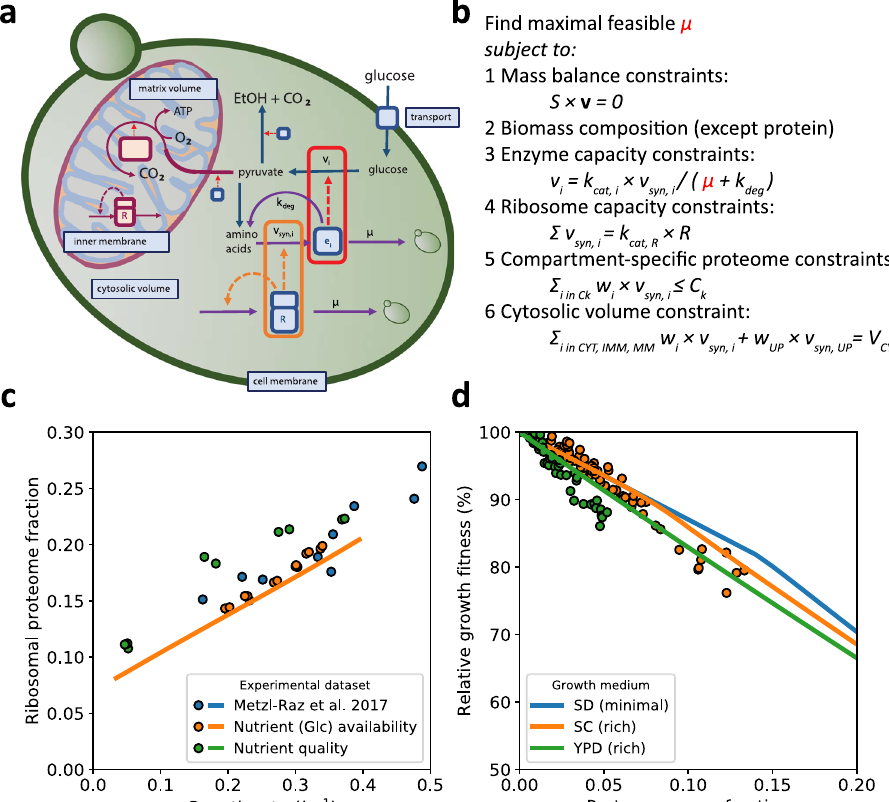
Fig. 1 pcYeast model formulation and calibration of protein synthesis parameters. a A schematic overview of reactions in the model, their interdependence and constraints. Metabolic reactions v i are proportional to enzyme concentrations e i that are synthesised at rate v syn ; i by the ribosomes R . Each protein can be degraded with rate v deg ; i ¼ k deg (cid:2) e i or diluted by growth rate v dil ; i ¼ μ (cid:2) e i . Compartment-speci fi c constraints are indicated in the light- blue boxes. b Optimisation problem with the key constraints, including (1) steady-state mass balances; (2) production of biomass components such as DNA, lipids, cell wall and polysaccharides. Proteins are excluded as their synthesis rates are optimisation variables (3) enzyme capacity constraints that couple metabolic fl ux to catalytic rate k cat ; i and the enzyme level, whose value at steady state is determined by its synthesis rate. Note we use equalities and hence enzymes work at their maximal rate and minimal required protein levels are computed; (4) ribosome capacity that de fi nes an upper bound for protein synthesis rate; (5) compartment-speci fi c proteome constraints that de fi ne the maximal concentration of proteins that can be contained in that compartment, with w i the speci fi c volume or area of protein i ; (6) a cytosolic protein density constraint that has the same function as that of proteome constraints, but whose equality forces the cell to fi ll up any vacant proteome space with unspeci fi ed protein UP. c Growth rate was varied through sugar type (trehalose, galactose, maltose, glucose) or glucose concentration, and ribosomal protein fraction was determined by proteomics. The translation rate was calibrated on the literature data (Supplementary Notes 6). d Impact of mCherry protein overexpression on growth rate. Symbols show experimental data 64 , solid lines show model predictions based on glucose minimal (SD) medium or rich SC/YPD media. Model predictions were obtained by varying the proteome mass fraction, occupied by mCherry, and determining the maximal predicted growth rate at each value of the mass fraction. The relative growth fi tness represents the ratio between the growth rate at certain mCherry expression level vs. the unperturbed state (no mCherry expression). Source data for panels c and d are provided as a Source Data fi